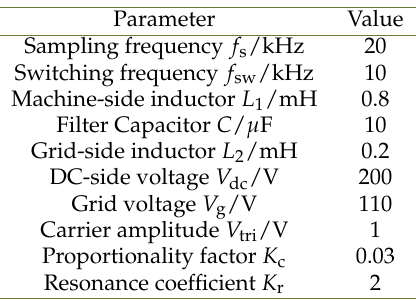
Table 1. Parameters of grid-connected